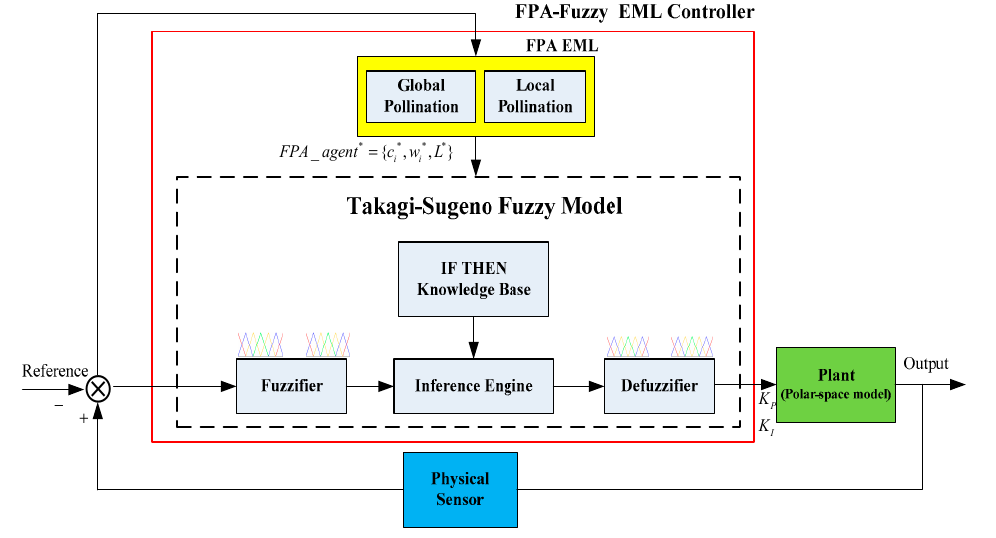
Figure 3. Architecture of the FPA-fuzzy evolutionary machine learning (EML) controller.